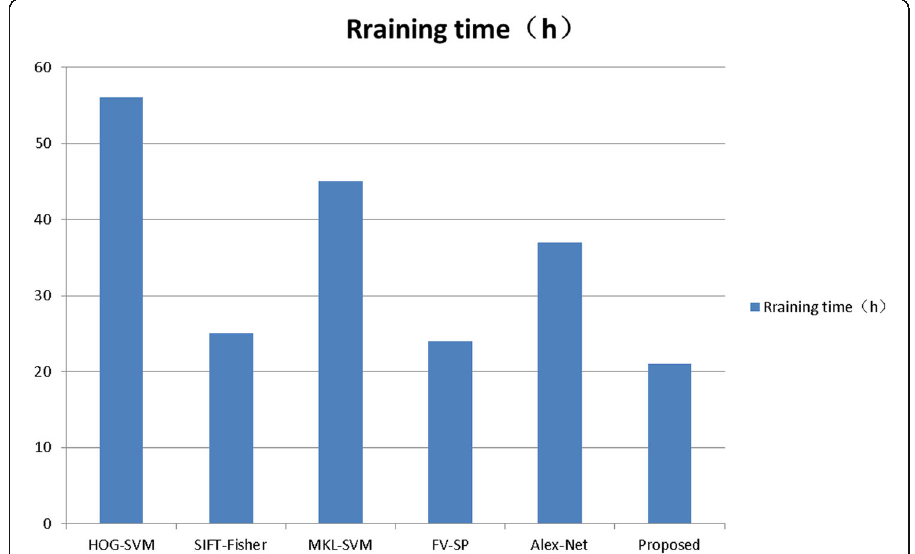
Fig. 5 The comparison of training